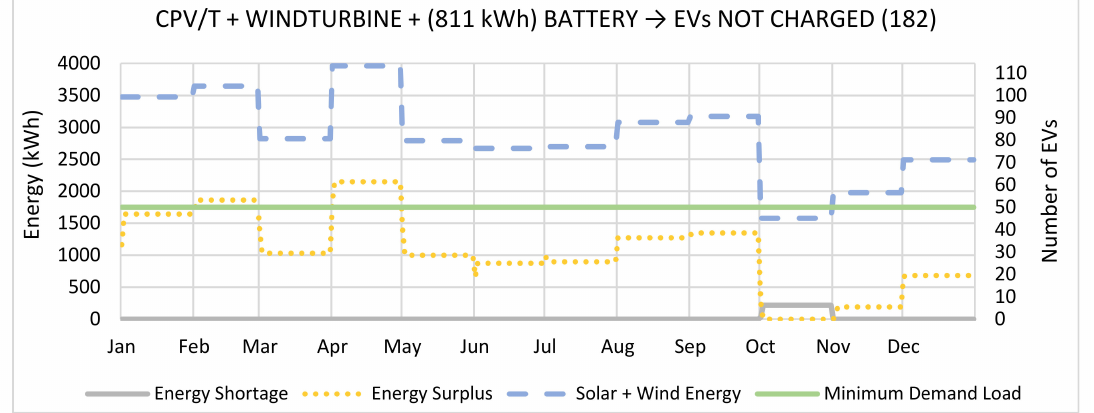
Figure 12. CPV / T, WT and amended BSS size annual simulation results.